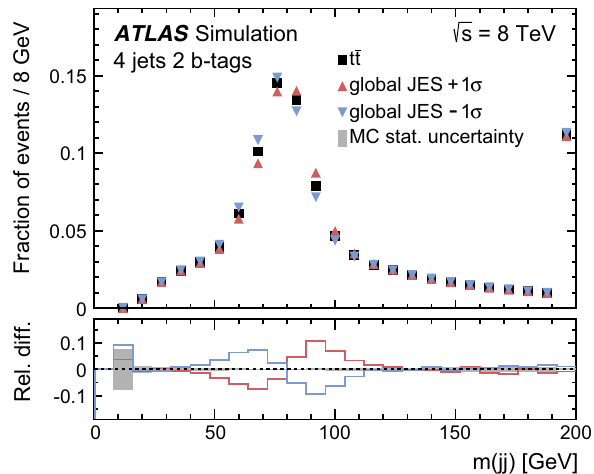
Fig. 5 Probability density of the m ( jj ) distribution from simulated t ¯ t eventsinSR2forthenominalJESandthe ± 1 σ variation.Thelowerhis- togram shows the relative difference between the numbers of t ¯ t events for the ± 1 σ JES and the nominal JES in each bin with respect to the nominal JES. The grey error band represents the statistical uncertainty of the sample. Events beyond the x -axis range are included in the last